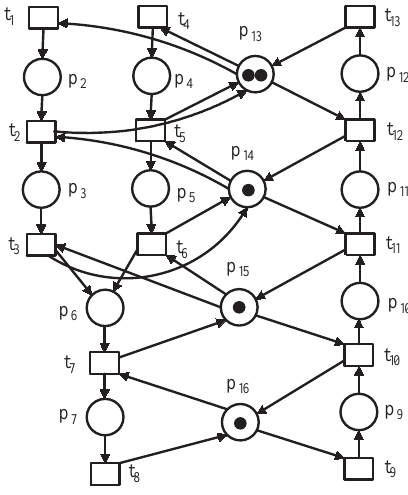
Figure 8. A subnet model ( N (cid:48) , M 0 ) for an